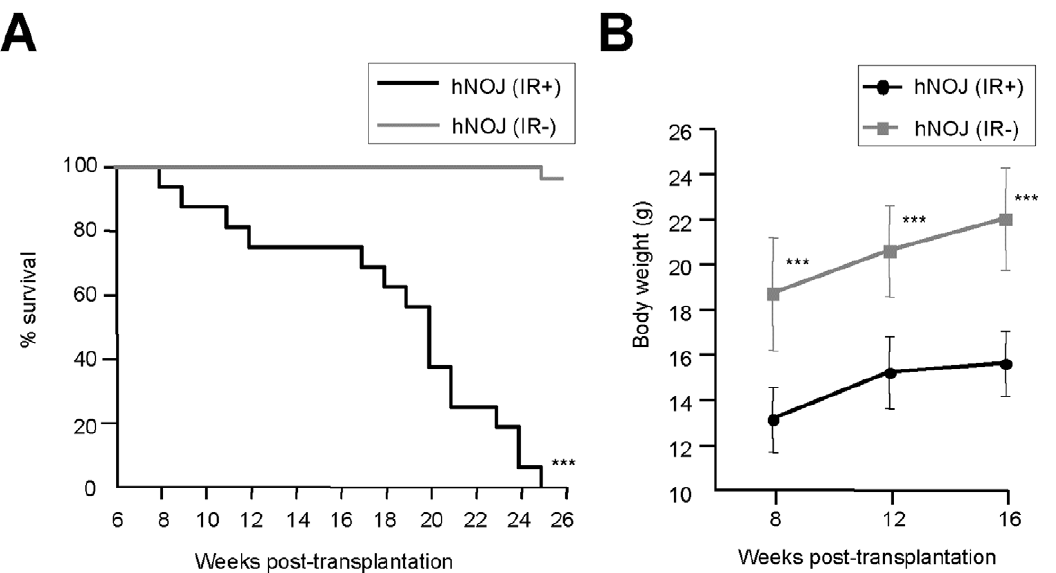
Figure 1. Influence of irradiation on the survival and growth of hNOJ mice. Newborn NOJ mice (1 2 2 days after birth) were irradiated (1 Gy) or not before transplantation with CD34 + CD133 + HSCs isolated from human cord blood. (A) Survival curves for hNOJ (IR + ) and hNOJ (IR 2 ) mice ( n =16 and n =28, respectively). Significant differences ( *** P , 0.001) were determined by the log-rank test. (B) Changes in the body weight of hNOJ (IR + ) and hNOJ (IR 2 ) mice ( n =7 and n =10, respectively). Data are expressed as the mean 6 SD. Significant differences ( *** P , 0.001) were determined by the unpaired t test.